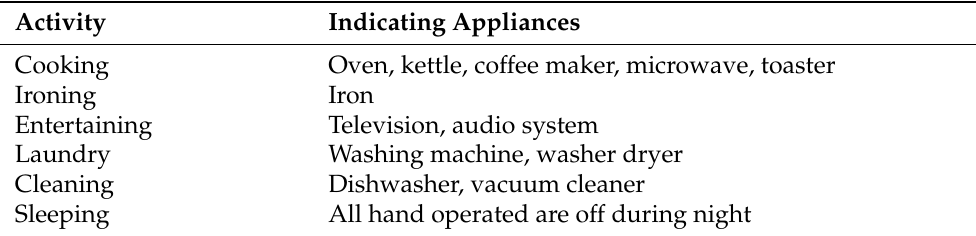
Table 1. An example of instrumental daily activities and related